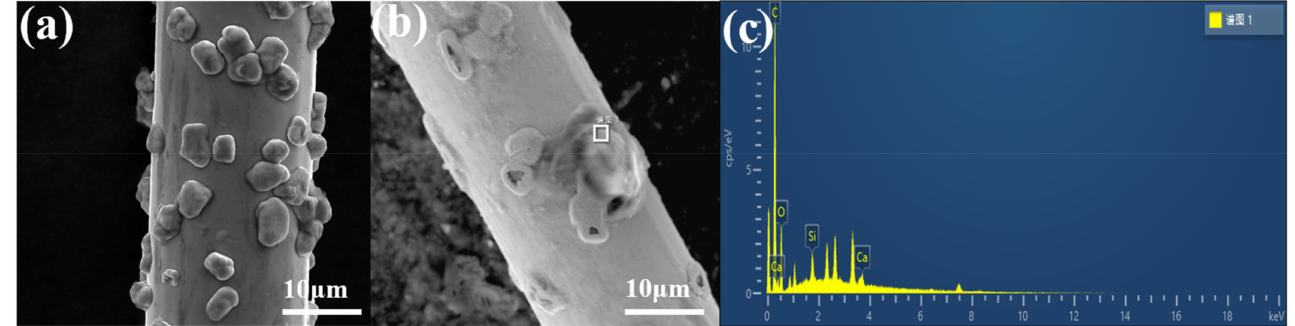
Figure 3. ( a ) SEM image of fresh diamond wire, ( b ) SEM image of waste diamond wire, ( c ) EDS spectrum of waste diamond wire surface substances.